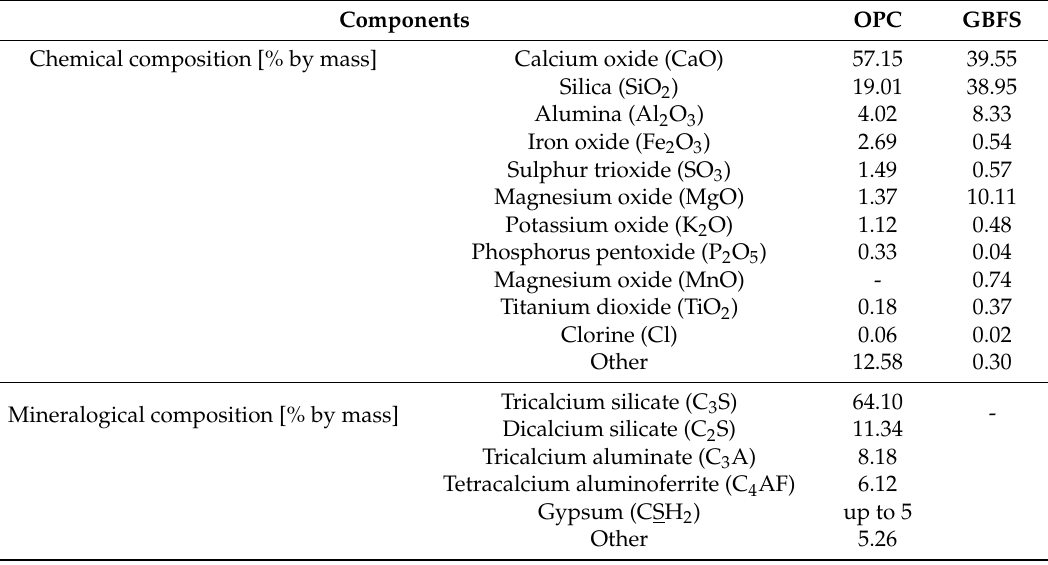
Table 1. Cement and slag